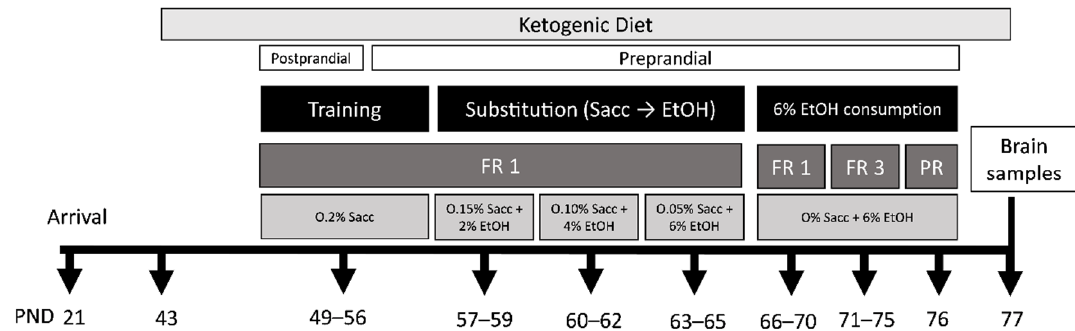
Figure 1. Experimental design for the 1st set of mice. FR, fixed ratio; PR, progressive ratio; PND, postnatal day; Sacc, saccharin; EtHO, ethanol.